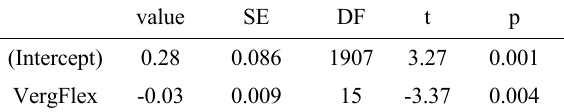
Table 7: Distribution of vergence facility subjects